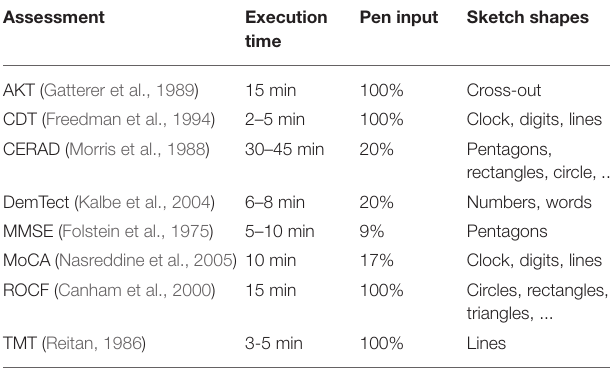
TABLE 1 | Comparison of widely used cognitive assessments including the percentage of tasks with pen input that contribute to the total